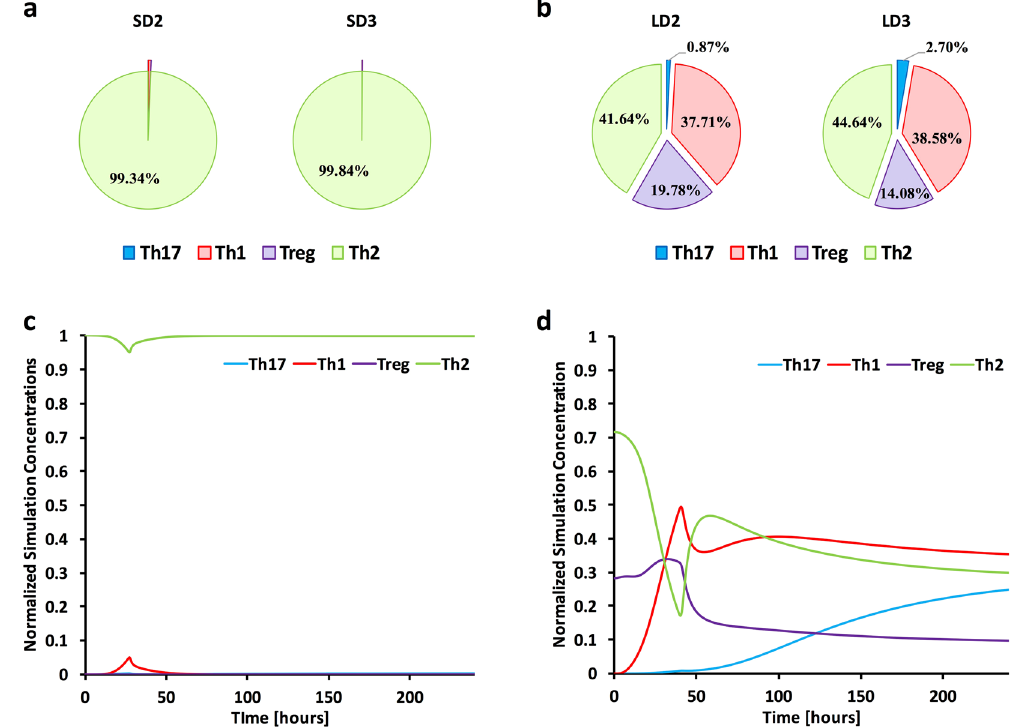
Figure 4. Predictive systems modeling of CD4 + T cell differentiation. Cytokine (IL-18, IL-12, IFN- γ , IL-21, IL-6, IL-17, IL-23, IL-4, TGF- β , IL-2, IL-10) and receptor (IL-18r, IL-12r, IFN- γ r, Il-6r, IL-17r, IL-23r, IL-4r, TGF- β r, IL-2r, IL-10r), and transcription factor (Tbx21, Gata3, Foxp3, Rorc) expression data was compiled and used as input for computational simulations. In silico models were separately calibrated using the particle swarm method. ( a,b ) The overall predicted CD4 + subset composition for day 2 and day 3 for both the steroid and chemotherapeutic models. ( c,d ) Model specific time course predictions from 0 to 240 hours post inoculation for the steroid and chemotherapeutic model. Steroid Model, S; Chemotherapeutic Model, L; Day 2, D2; Day 3,